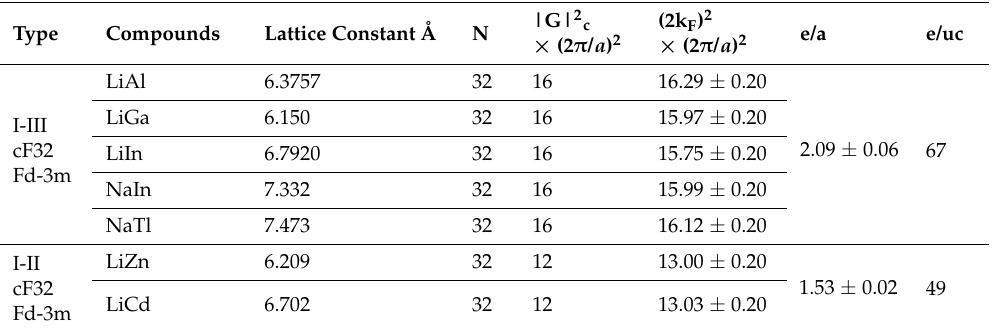
Table 7. Electronic properties for Zintl compounds (cF32).